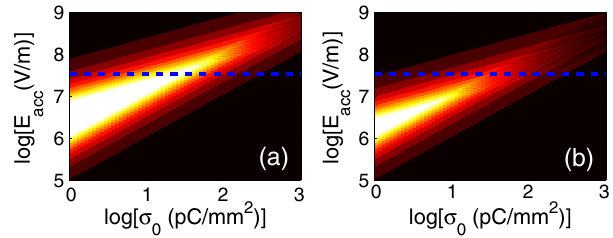
FIG. 1. Domain of existence of the blow-out regime (lighter colors) in the ð (cid:2) 0 ; E acc Þ parameter space for (cid:1) l ¼ 50 fs (a) and ¼ 200 fs (b). The horizontal blue dashed lines correspond to (cid:1) l ¼ 35 MV = m . (This figure was adapted from Ref. E 0